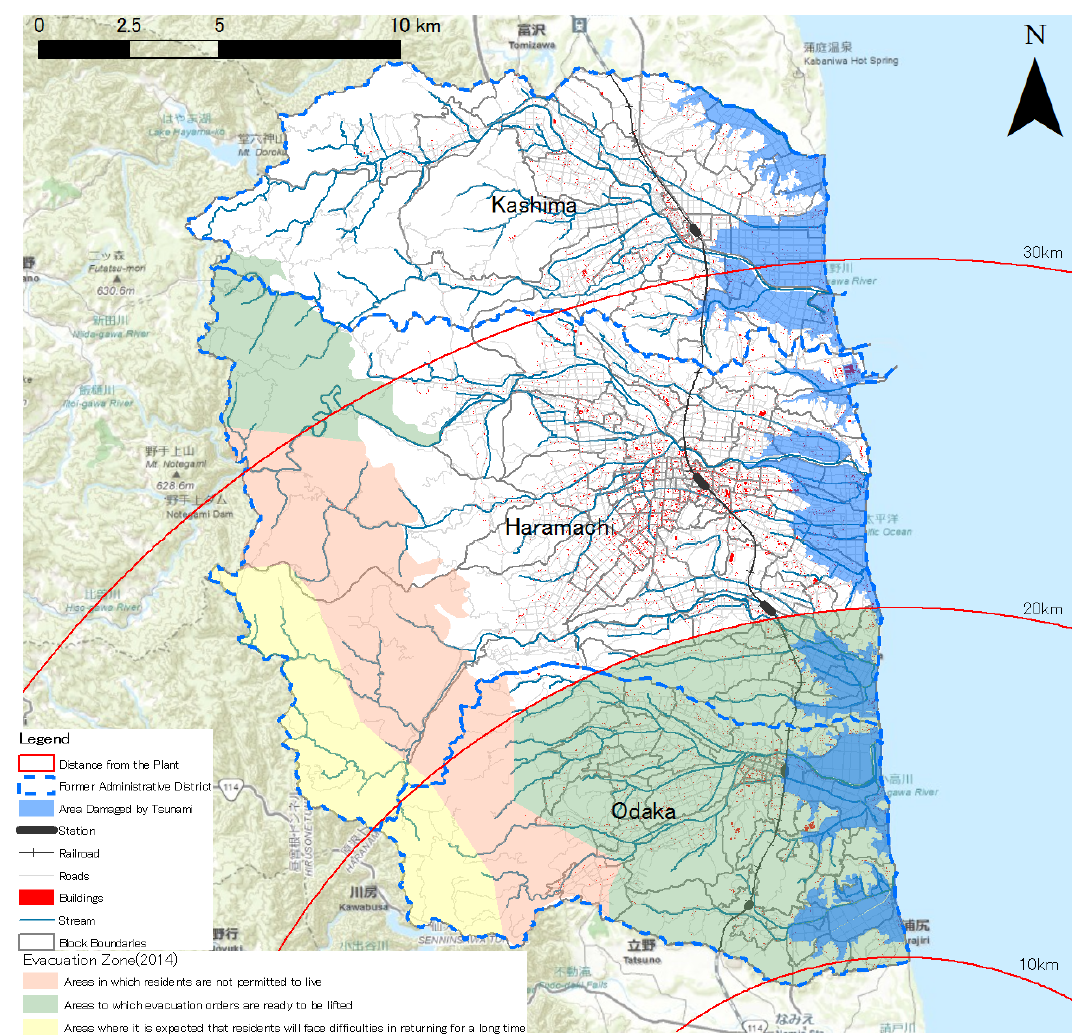
Figure 2. The Evacuation Zone in Minamisoma Established after the Fukushima Accident